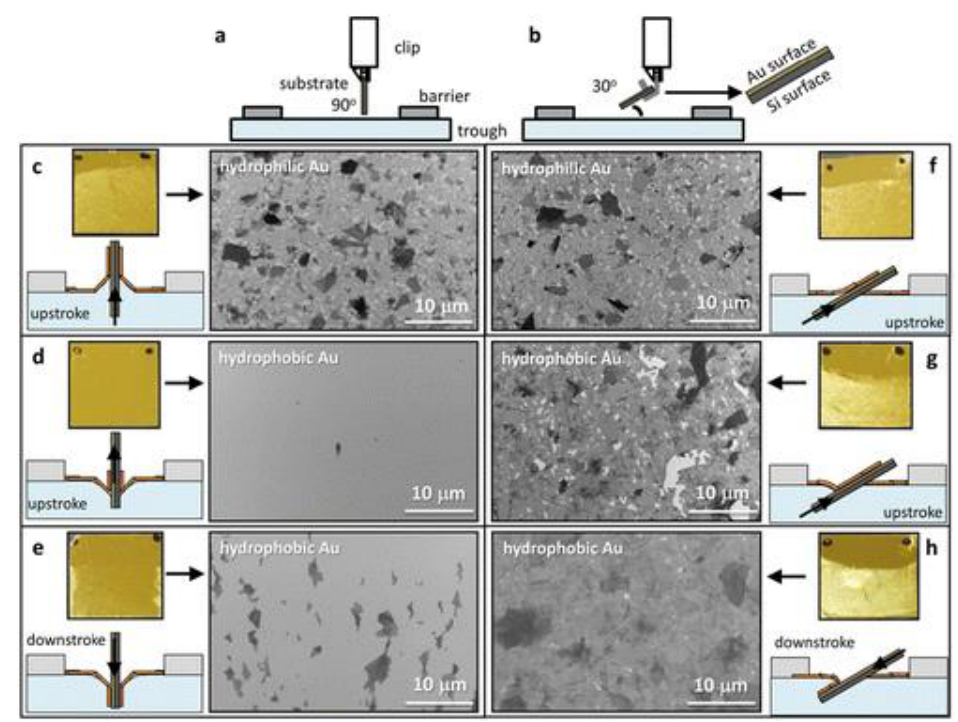
Figure 3. A comparison of conventional ( a ) 90° and ( b ) 30° dipping mechanisms of upstroke and downstroke of different hydrophobic and hydrophilic substrates. The SEM images show the comparison of the GO film formations in the upstroke ( c , f ) hydrophilic and ( d , g ) hydrophobic substrates of Au at both 90° and 30°. ( e , h ) SEM film formations as a result of downstroke using a hydrophobic Au substrate. Reprinted with permission from the Journal of the American Chemical Society, copyright 2015, American Chemical Society [44].